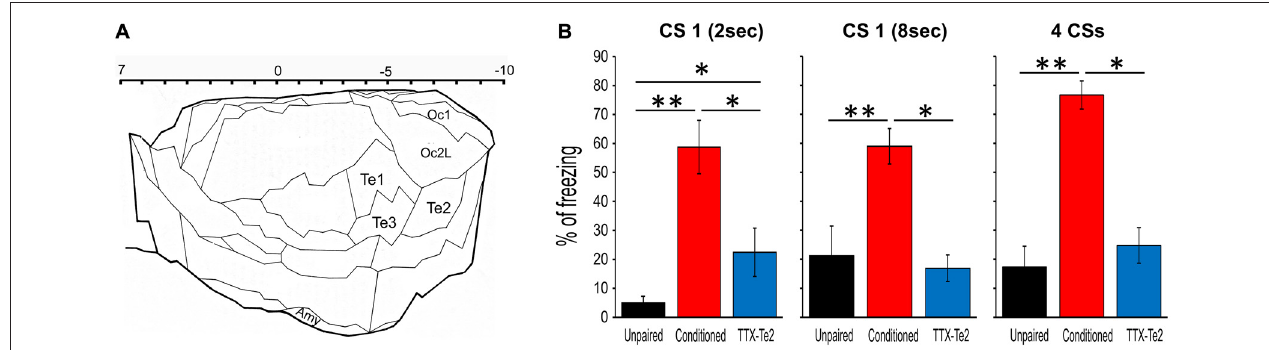
FIGURE 1 | Reversible inactivation of the higher order auditory cortex Te2 impaired the expression of fear behavior during remote retrieval of auditory fearful memories. (A) Schematic representation of the secondary sensory cortices included in the present study. The upper scale indicates positive and negative distances from bregma. Plate adapted from Zilles (1985). (B) Percentage of freezing to the first 2 s of the first CS (left), the entire 8 s of the first CS (middle) and the overall four CSs (right) for the unpaired, conditioned and tetrodotoxin citrate (TTX)-injected rats. All data were mean ± SEM. Te1, primary auditory cortex; Te2 and Te3, secondary auditory areas; Amy, amygdala; Oc1, primary visual cortex; Oc2L, secondary visual areas (lateral). ∗ P < 0.05; ∗∗ P < 0.01.